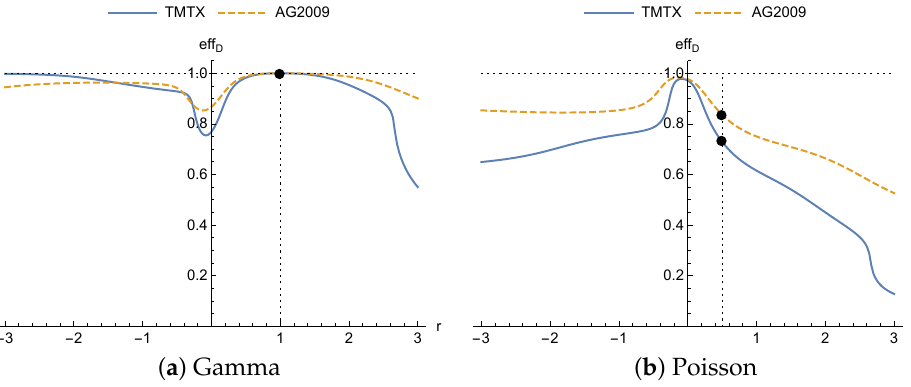
Figure 2. Efficiencies when comparing the designs obtained for the heteroscedastic normal distribu- tion with variance given by (5) and different values of r when the true distributions are the gamma ( a ) and Poisson ( b ), for the 4-parameter Hill model using the nominal values of Table 4. The graphs for the drugs MTX, AG2032 and AG2034 are similar to the graph for the drug TMTX. For that, the effect of r on the trend of the efficiency is studied depending on the values taken by η ( x ; θ ) . Again, in this analysis, it is assumed that y follows a heteroscedastic normal distribution with variance structure given by (5) when the distribution of y is the Poisson or the gamma and a misspecification takes